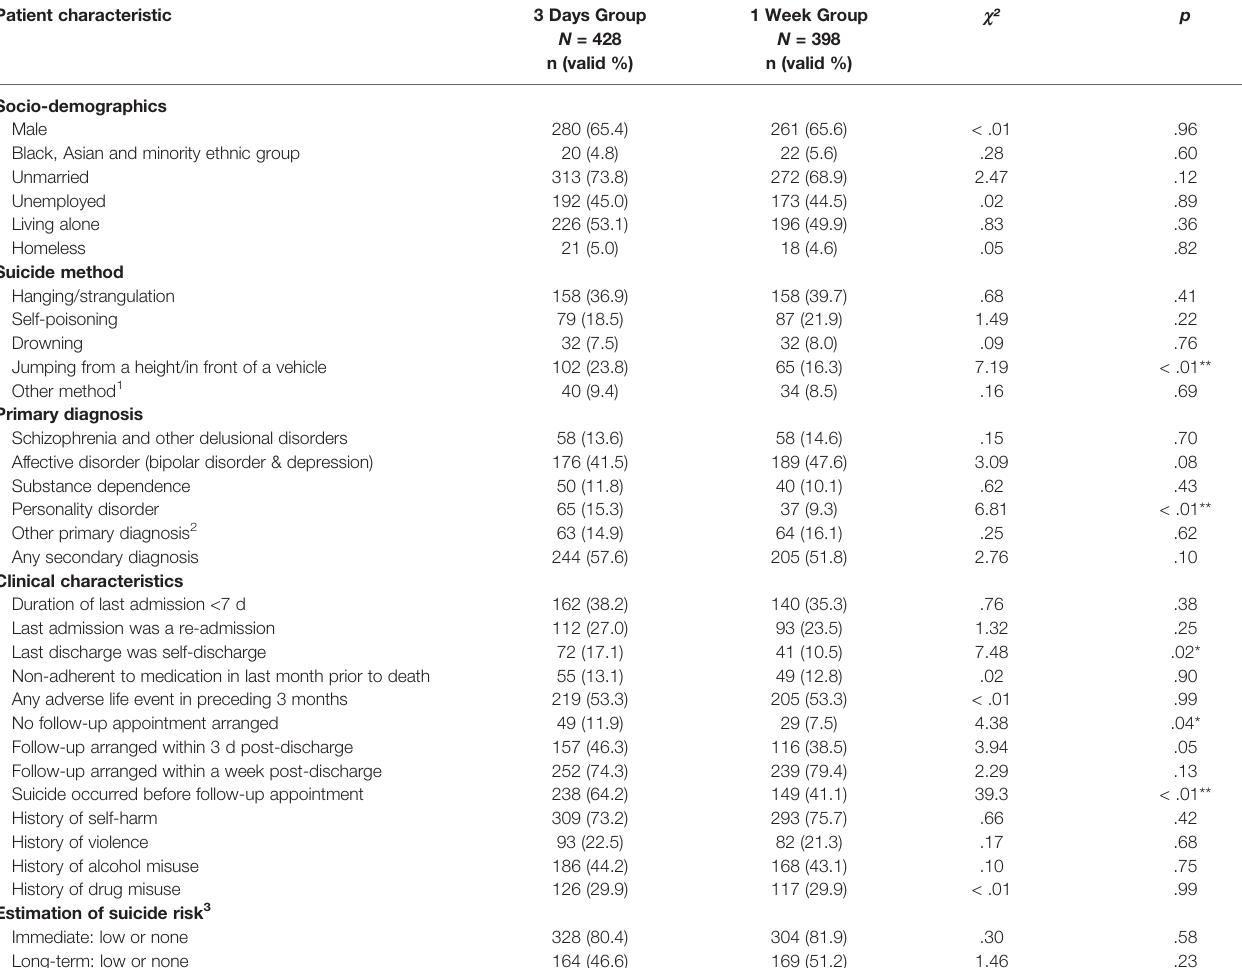
TABLE 1 | Sociodemographic and clinical characteristics of patients who died within a week post-discharge ( N = 826). Patient